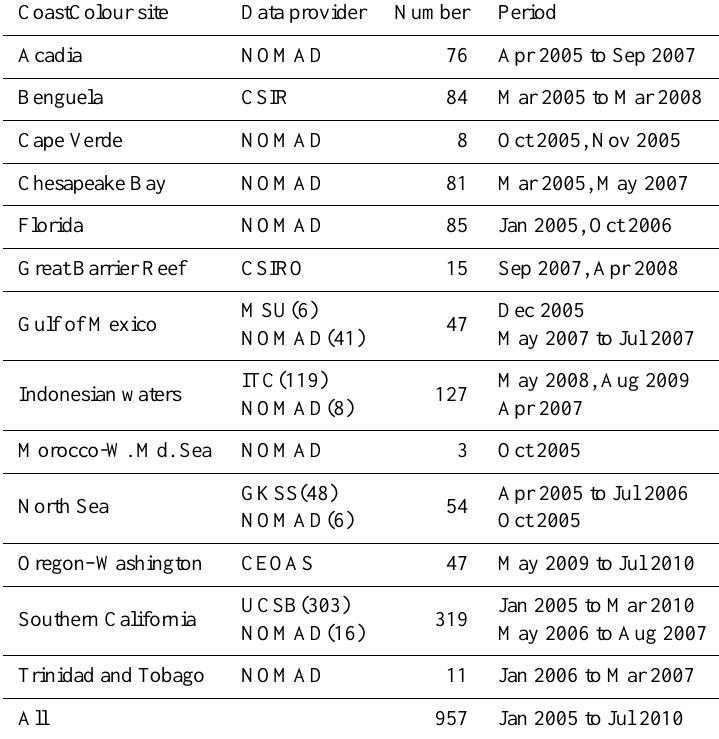
Table 5. Number and period(s) of match-up field RLw measurements in each CoastColour site and by data